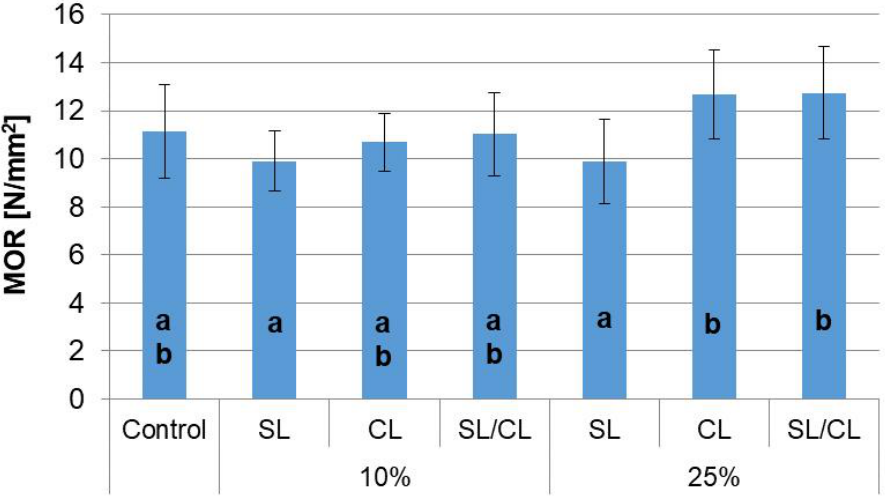
Figure 4. Modulus of rapture of particleboards. a,b — homogenous group by Tukey test.